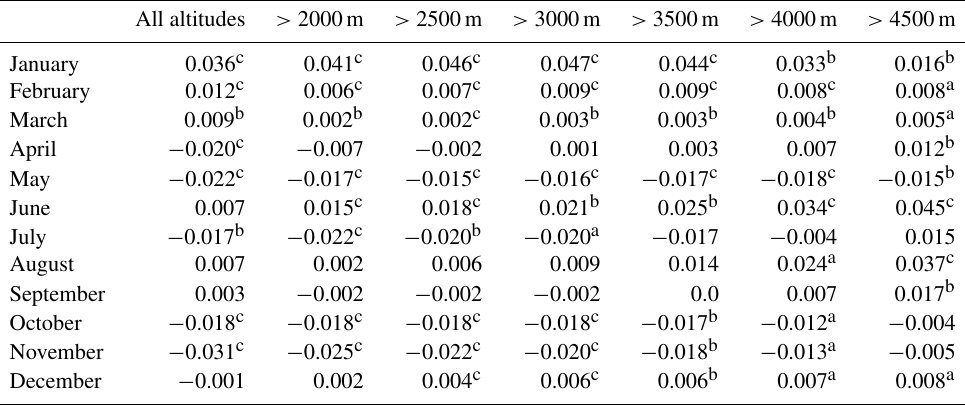
Table 6. Significance of elevation-dependent warming for monthly T mean above different altitude thresholds based on the CTMD from 1979 to 2016.